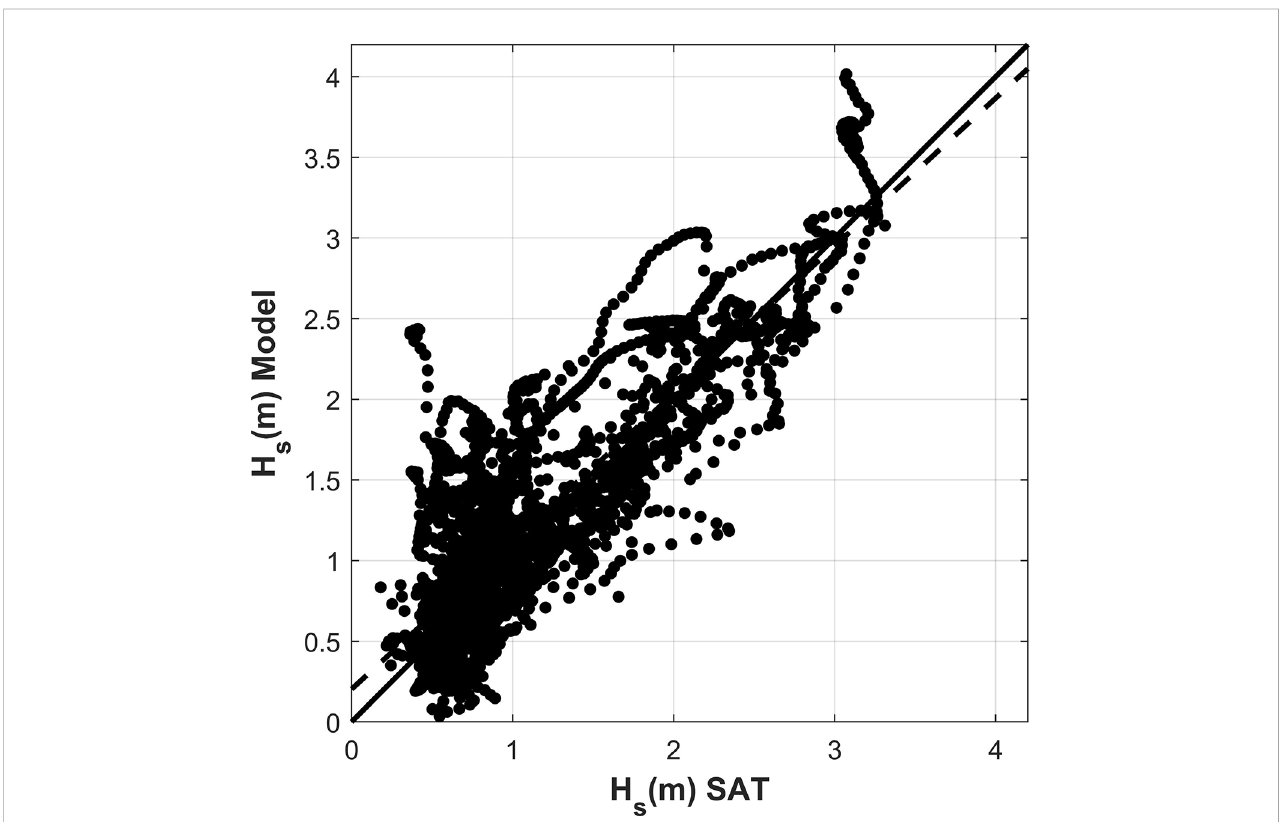
FIGURE 3 Scatter diagram of signi fi cant wave height from the satellite data and corresponding model outputs. The solid black line indicates the ideal fi t and the black dashed line shows the linear regression for the two datasets, with a slope of